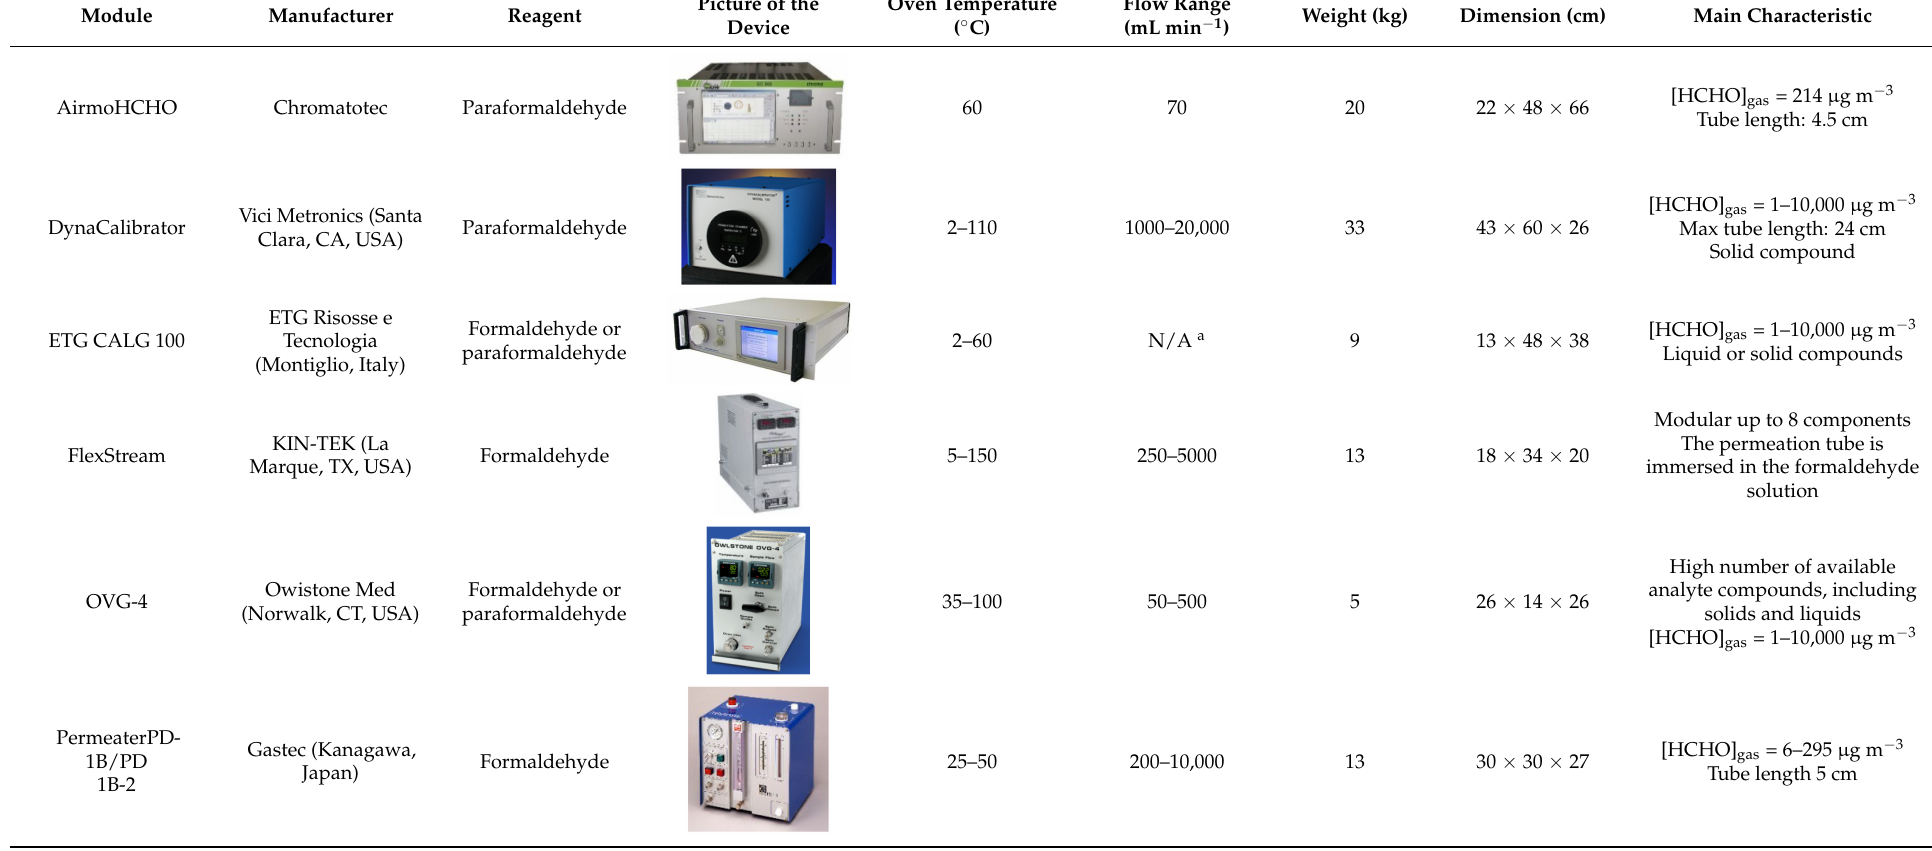
Table 2. Commercial devices for generating gaseous formaldehyde based on the permeation tube